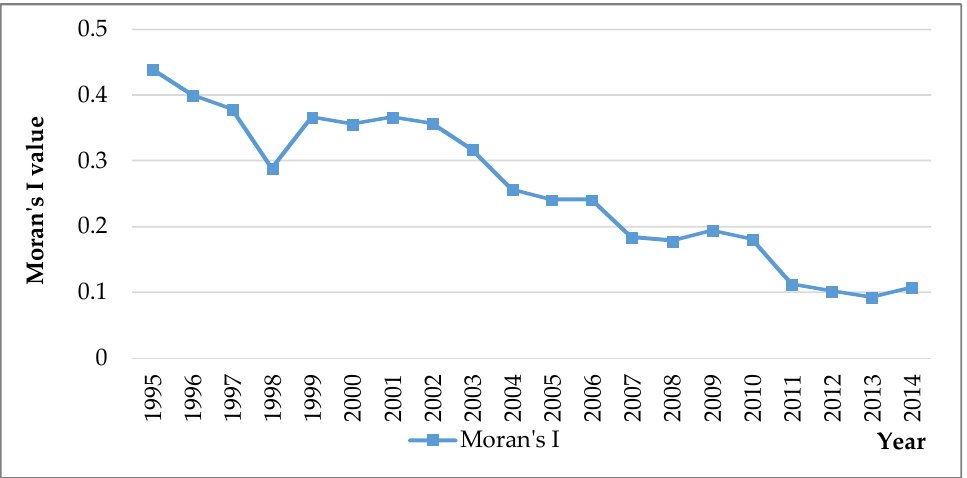
Figure 8. The trends of global Moran’s I during 1995–2014.